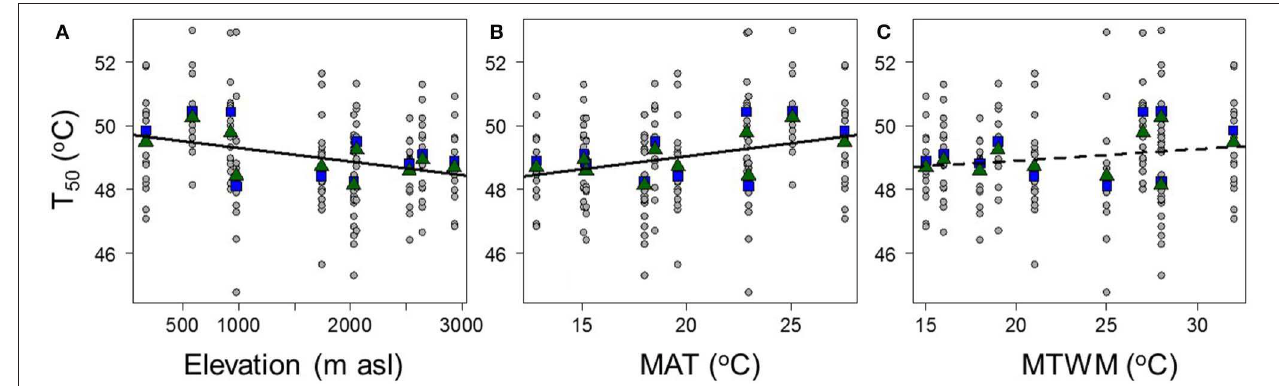
FIGURE 2 | The relationships between species’ thermal tolerances (T 50 ) and (A) plot elevation, (B) mean annual temperature (MAT), and (C) mean maximum temperature of the warmest month (MTWM). Circle points and lines show species-level data; square points show plot-level averages with the species weighted by their relative abundances, and triangle points show unweighted plot averages. T 50 = 49.72 ◦ -0.0004 × Elevation, R 2 = 0.07, P = 0.00101; T 50 = 47.39 ◦ + 0.0827 × MAT, R 2 = 0.07, P = 0.00115; T 50 = 48.16 ◦ + 0.0372 × MTWM, R 2 = 0.02, P =